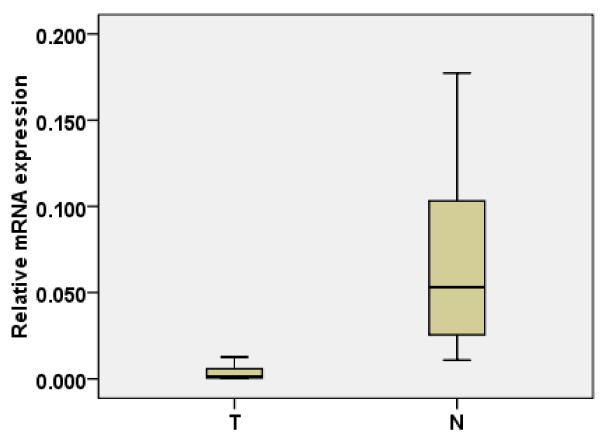
Real-time quantitative RT-PCR analysis of DUSP-9 expression. The relative expression of DUSP-9 mRNA in RCC tumor tissue samples was lower than that in the paired adjacent normal (N) tissue samples (n = 46, P < 0.001). The bottom and the top of the box represent the 25th and the 75th percentile, respectively, and the band near the middle of the box is the 50th percentile (the median). The ends of the whiskers represent the 2.5th percentile and the 97.5th percentile.